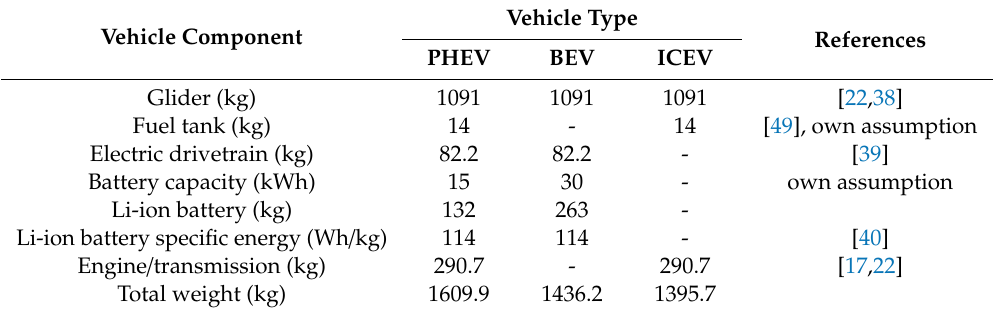
Table 1. Mass of vehicle components used in this study for all